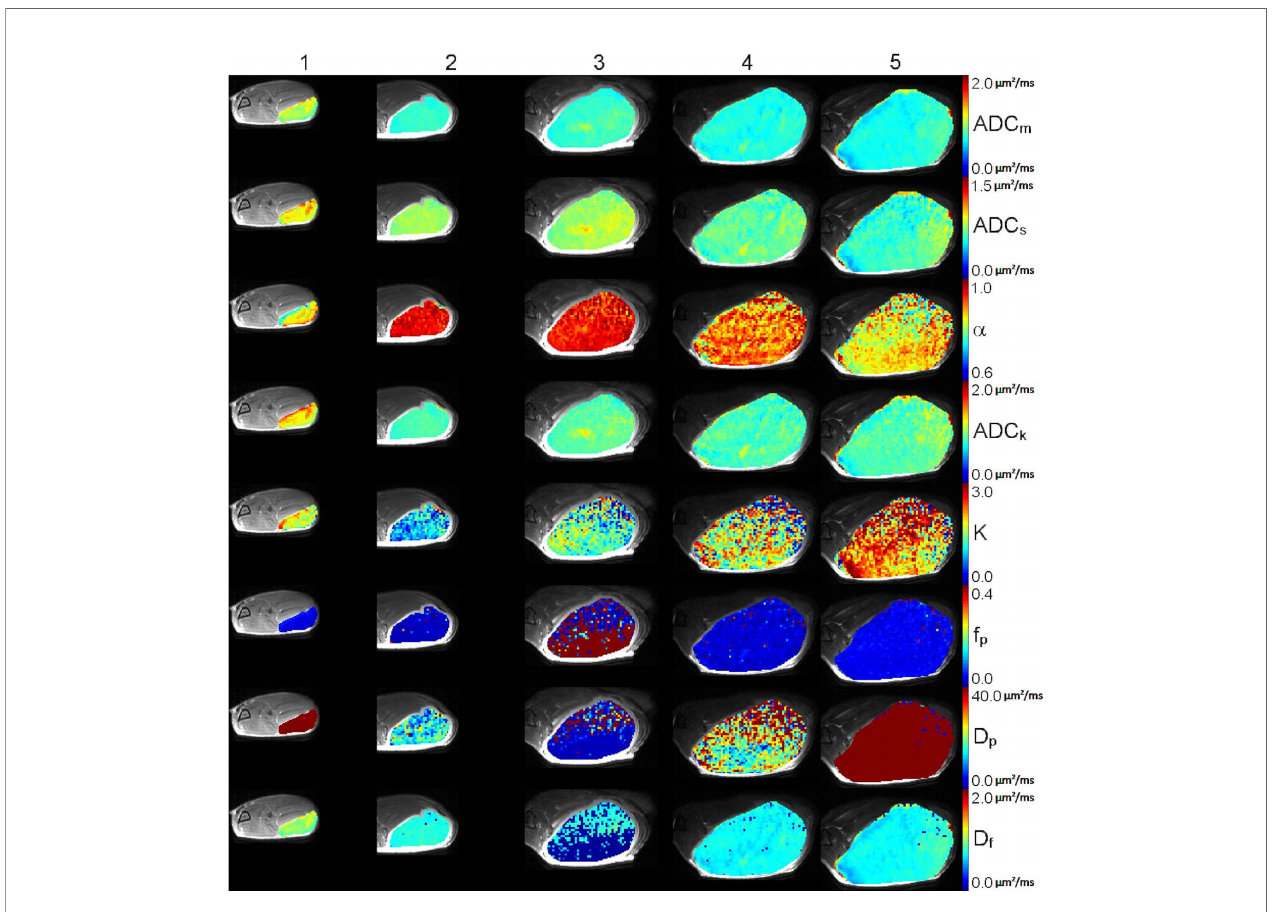
FIGURE 1 | Low b-value DWI data of a representative tumor: T2-weighted image fused with parametric maps for ADC m, ADC s , a , ADC k , K, f p , D p , and D f parameters are shown, and represent different degree of tumor homogeneity between week 1 (column 1), week 2 (column 2), week 3 (column 4) and week 4 (column 1). Furthermore, the second repeated imaging on week 4 is shown (column 5). The parametric maps are scaled as follows: ADC m, min − max: 0 − 2.0 µm 2 /ms; ADC s, min − max: 0 − 1.5 µm 2 /ms; a , min − max: 0.6 − 1.0; ADC k , min − max: 0 − 2.0 µm 2 /ms; K, min − max: 0 − 3.0; f p , min − max: 0 − 0.4; D p , min − max: 0 − 40.0 µm 2 /ms; D f , min − max: 0 − 2.0 µm 2